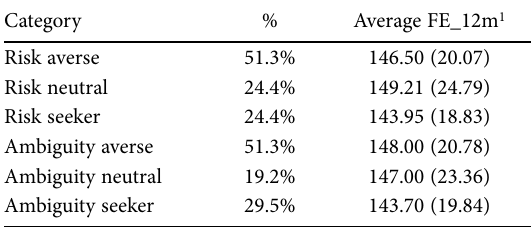
Table 2. Risk and ambiguity attitude (%) and future equivalent (N =